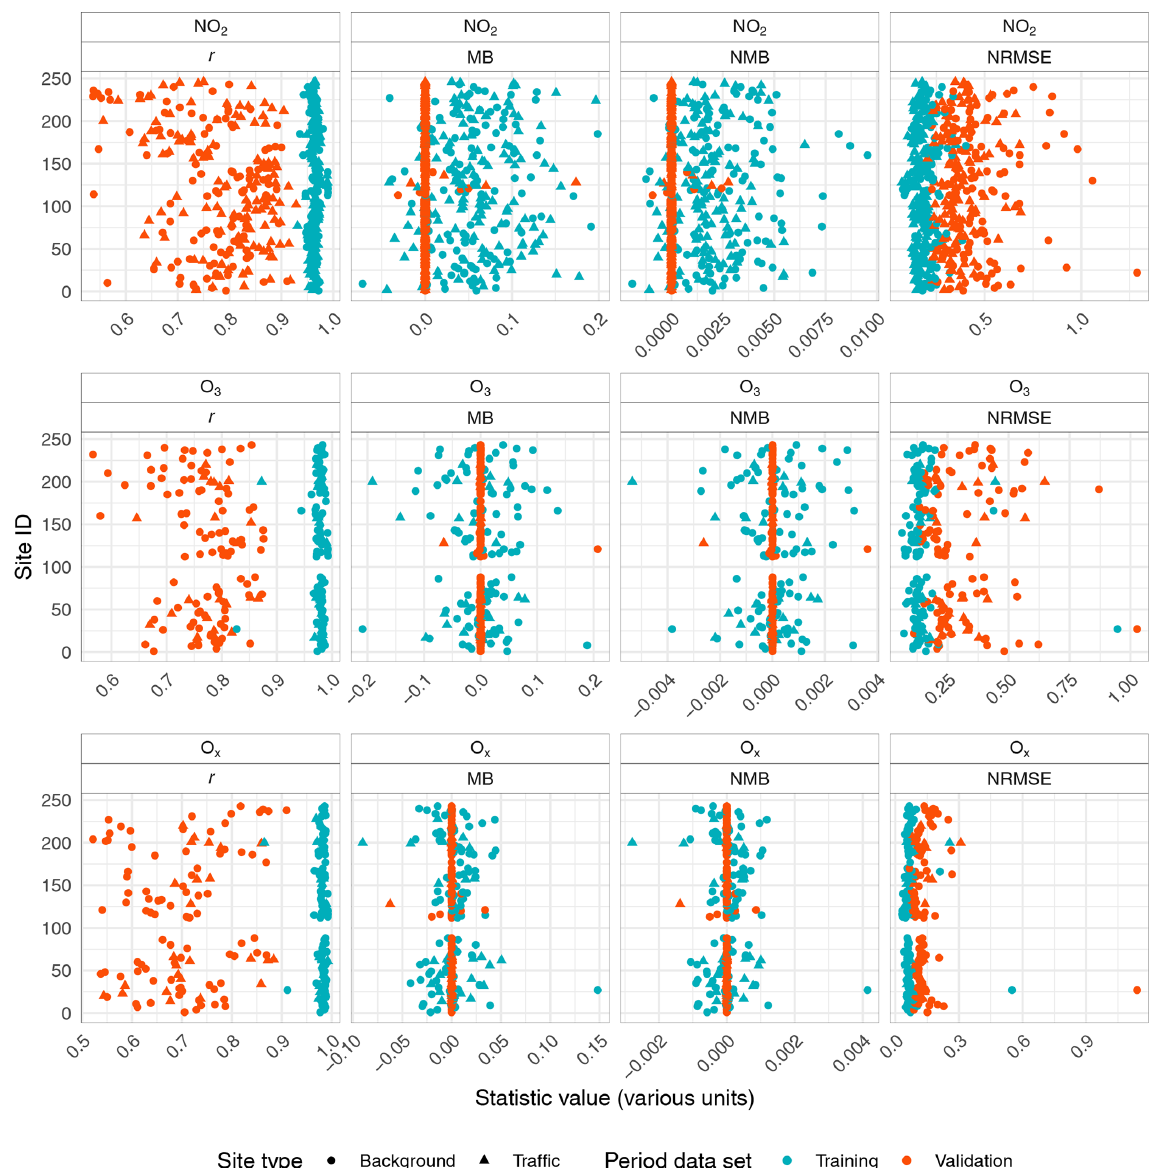
Figure A1. Model error summaries for all monitoring sites’ (coded as integers) NO 2 , O 3 , and O x models for two data sets: training sets and validation sets. The error summaries are the Pearson’s correlation coefficient ( r ), the mean bias (MB; in µgm − 3 ), the normalized mean bias (NMB), and the normalized root-mean-square error (NRMSE). The normalized values were normalized by the observed mean.